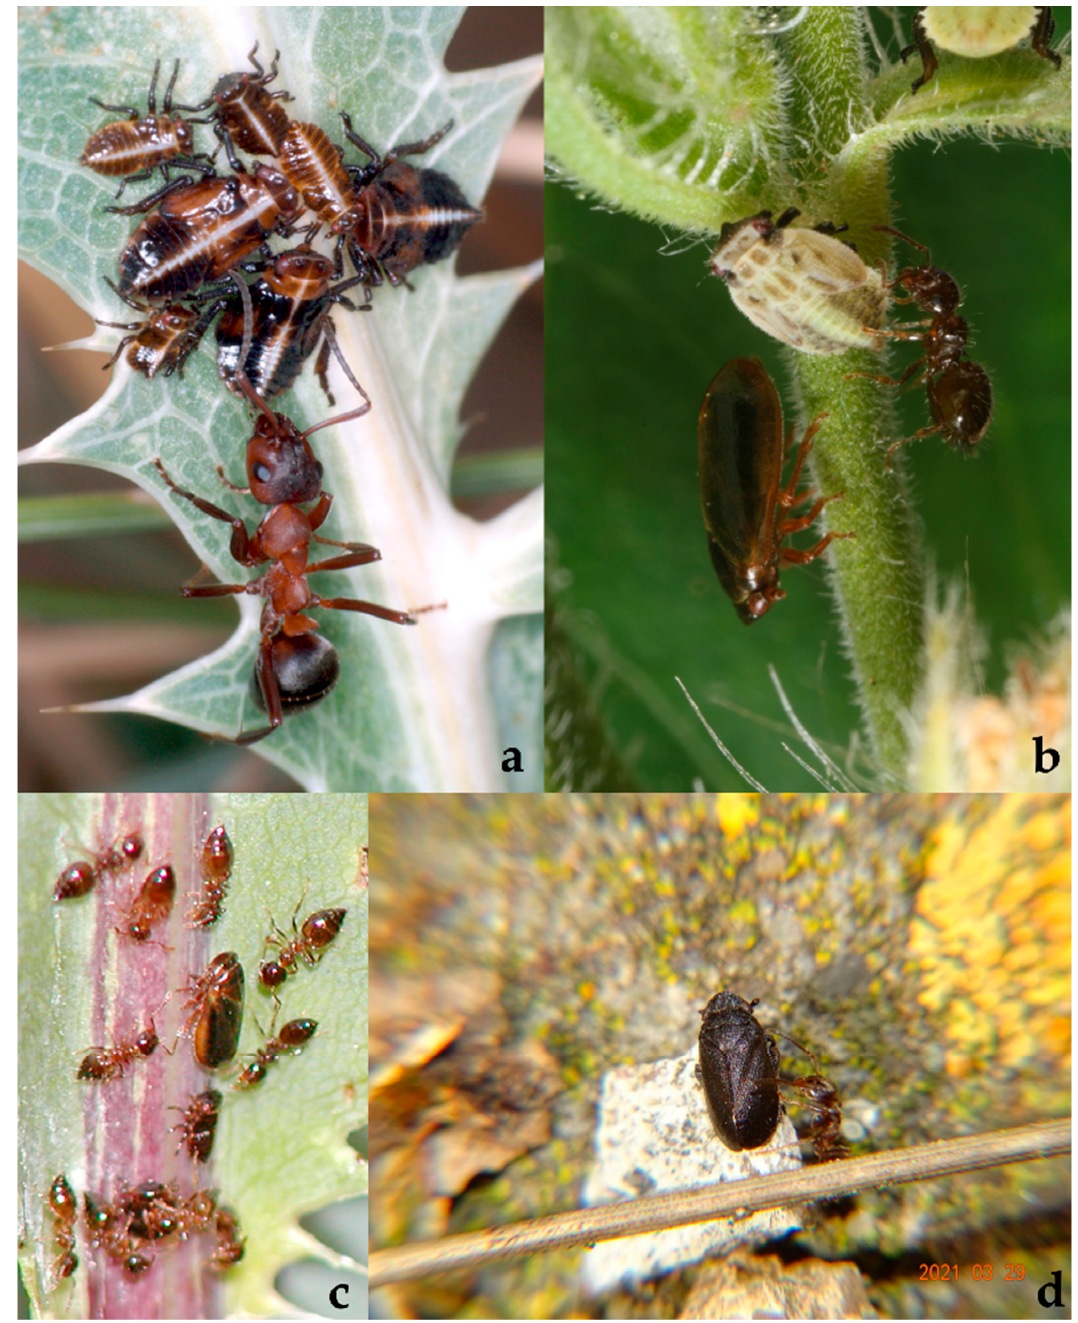
Figure 35. Tettigometridae ( a ) Tettigometra ( Mitricephalus ) macrocephala Fieber, 1864 tended by Formicidae: Formicinae: Formica sp., Bulgaria: Stara planina Mt., Saranci vill. 42°43 ′ 24.0 ″ N 23°46 ′ 58.0 ″ E, 25.07.2012, nymphs and adults on Eryngium campestre L. (Apiaceae), obs. I. Gjonov, A. Lapeva-Gjonova; ( b ) T. ( Metroplaca ) longicornis Signoret, 1864 tended by Formicidae: Myrmicinae: Crematogaster sordidula (Nylander, 1849), Bulgaria: Primorsko, Maslen Nos Cape, 42°18 ′ 31.7 ″ N 27°47 ′ 22.5 ″ E, 04.06.2021, obs. I. Gjonov, A. Lapeva-Gjonova; ( c ) T. ( Metroplaca ) longicornis tended by Formicidae: Myrmicinae: Crematogaster sordidula , France: Alpes de Haute-Provence, Sainte-Croix-du-Verdon, 43°46 ′ 21.0 ″ N 6°05 ′ 34.0 ″ E, 04.06.2003, nymphs and adults on Eryngium campestre (Apiaceae), obs. I. Gjonov; ( d ) T. ( Tettigometra ) sp. tended by Formicidae: Formicinae: Lasius sp., Germany: Eichstätt, Bayern, 48°53 ′ 10.0 ″ N 11°12 ′ 58.6 ″ E, 29.03.2021, adult, obs. T. Leilich.